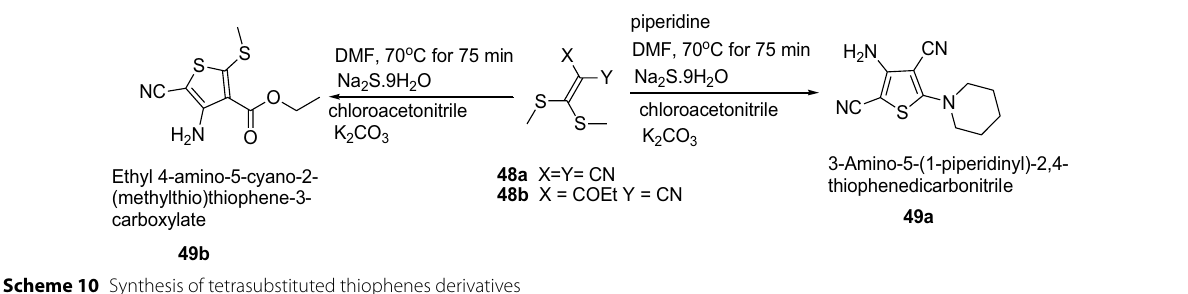
Table 11 Antibacterial activities of newly synthesized compounds Bacteria Inhibition zones (mm) 49a 49b DMSO Streptomycin B.